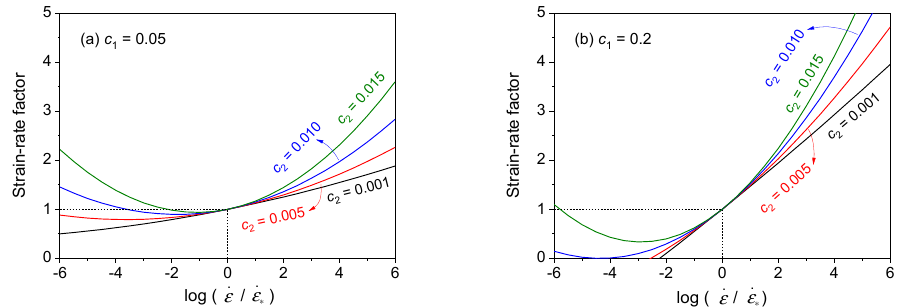
. . ε / ε ∗ ) for different values of c 2 when ( a ) c 1 = 0.05 and